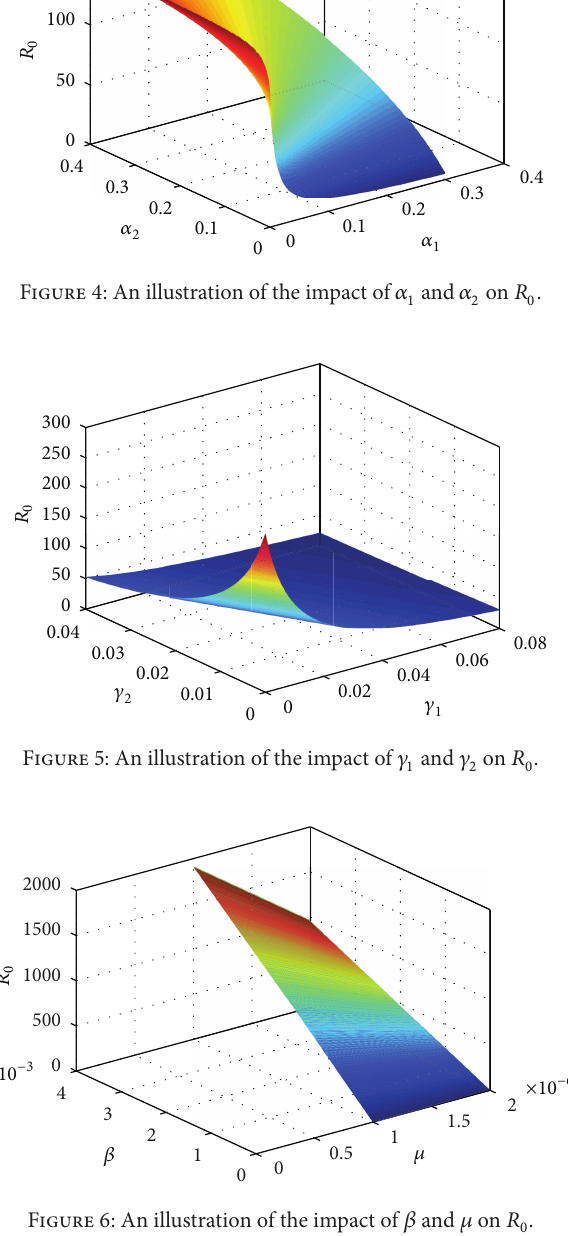
Figure 6: An illustration of the impact of 𝛽 and 𝜇 on 𝑅 0 .